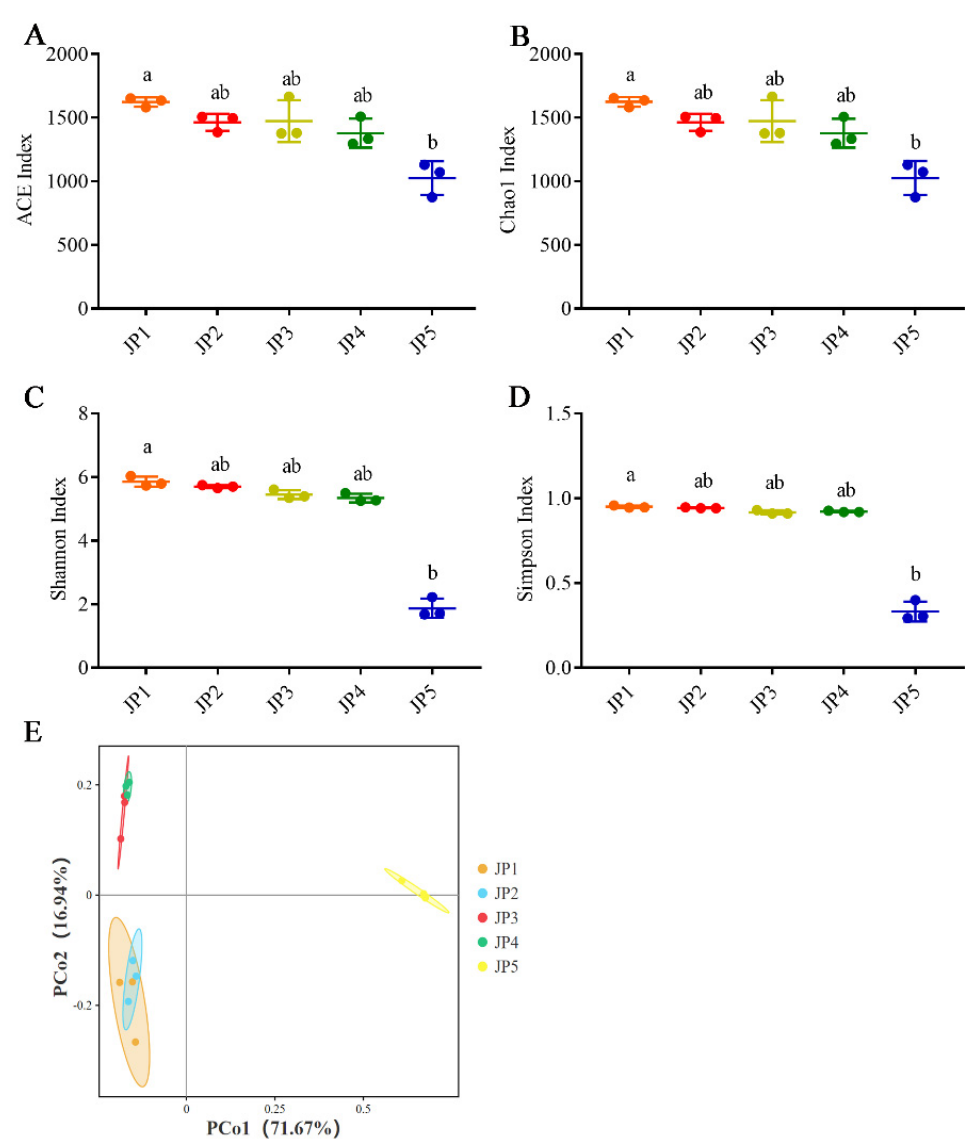
Figure 3. Alpha diversity and beta analysis based on sediments in Jingpo Lake. ( A ) ACE. ( B ) Chao1. ( C ) Shannon. ( D ) Simpson. ( E ) Principal coordinate analysis (PCoA). Statistical analyses of alpha diversity were performed using Kruskal − Wallis test. a,b Bars marked with different letters indicate significant differences ( p < 0.05). PCoA analysis was performed based on the Bray − Curtis